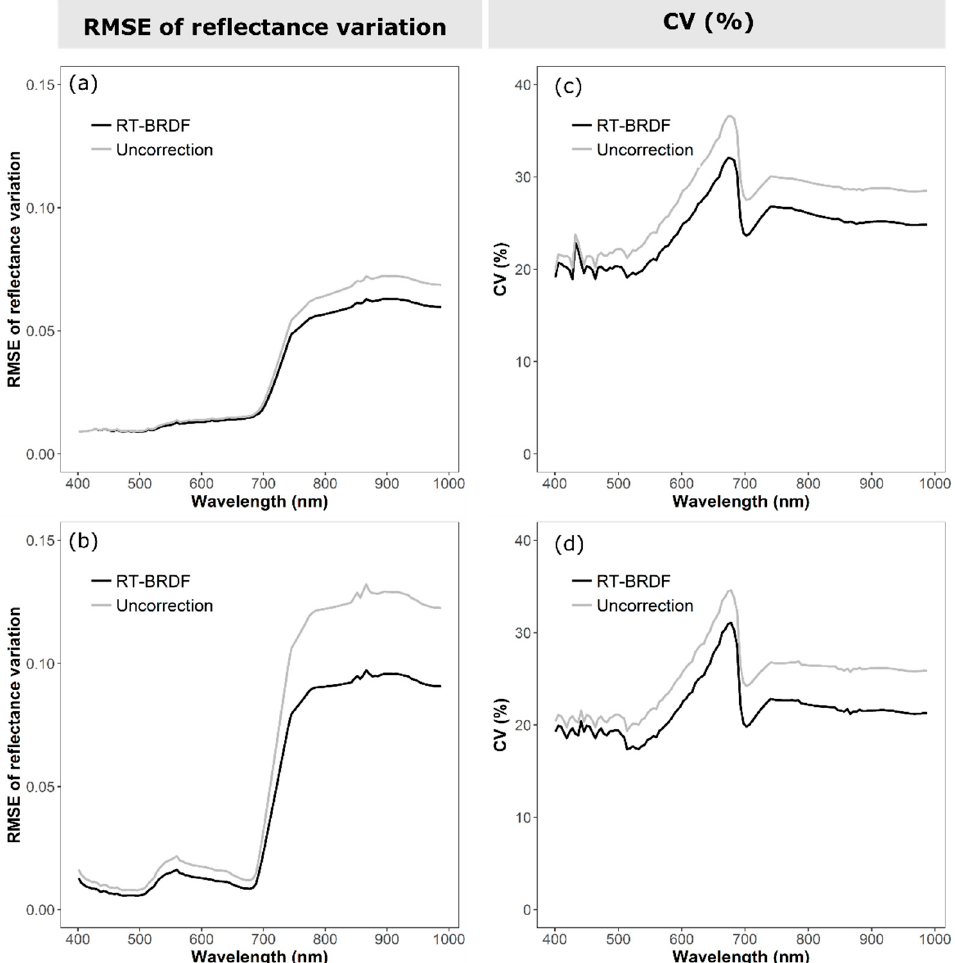
Figure 11. Pre- and post-RT-BRDF RMSE of the reflectance values variability for ( a ) coniferous and ( b ) broadleaved forest pixels from adjacent and overlapping hyperspectral images. The coefficient of variation (CV) (%) of ( c ) coniferous and ( d ) broadleaved forest pre- and post-RT-BRDF.